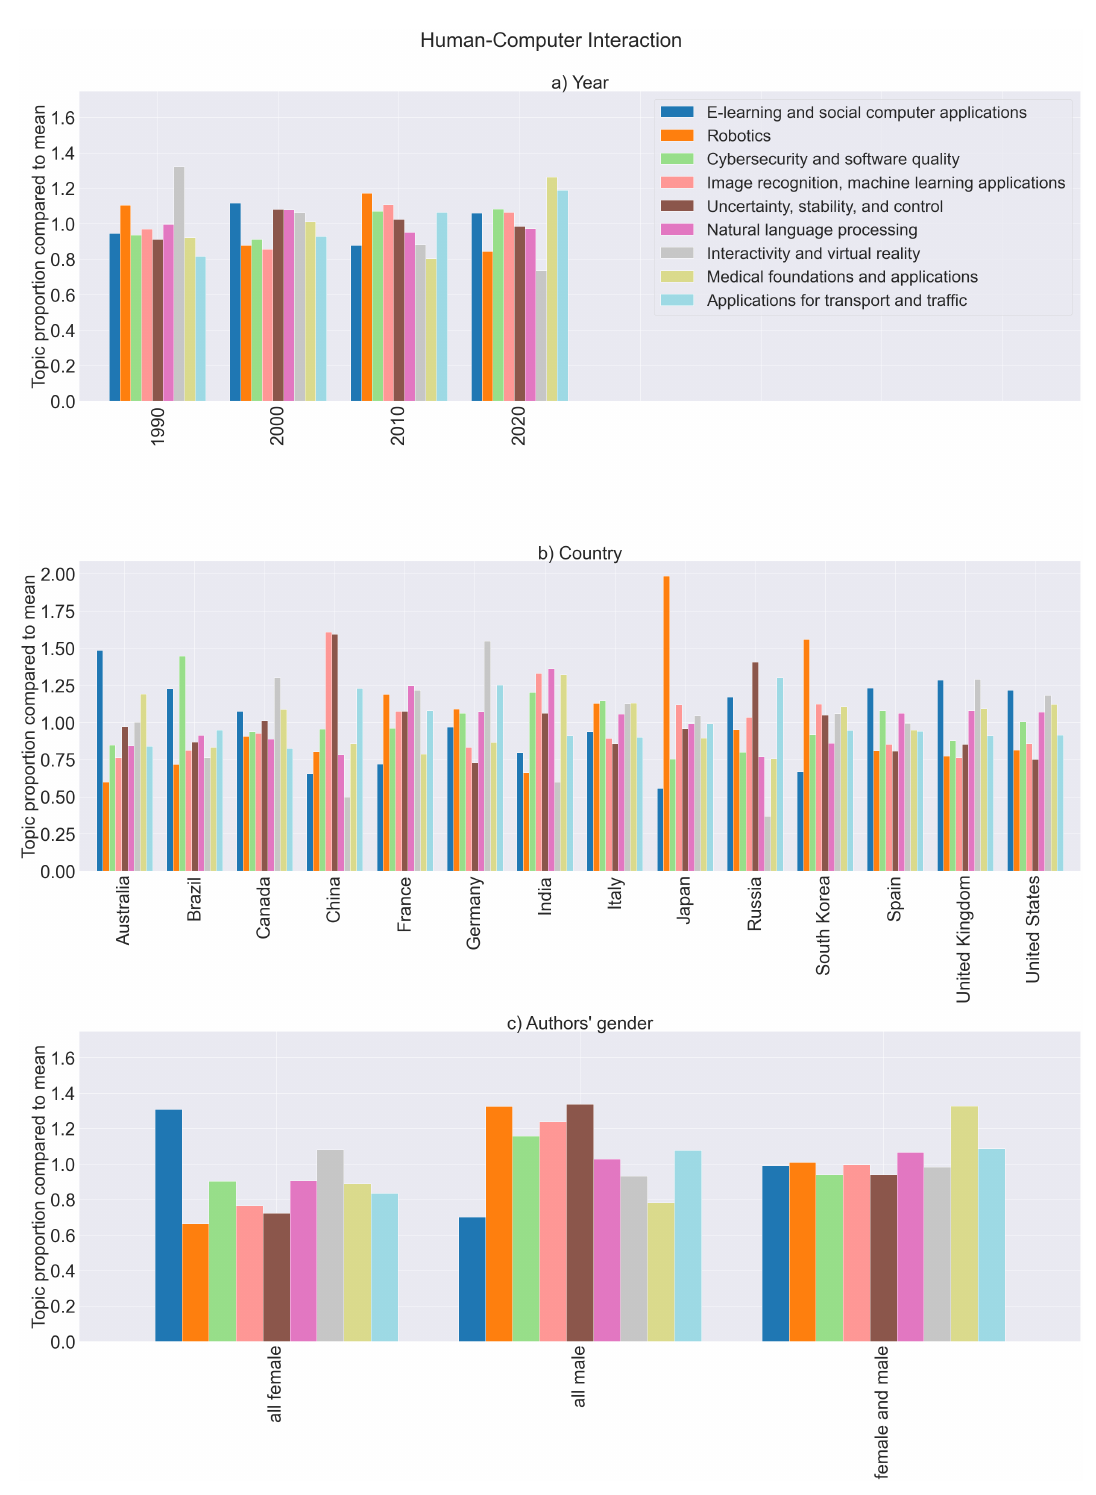
Figure 7. Topic proportion compared to mean, c κ ( ˆ D α ) , for 9 topics of the sub-area human-computer interactions grouped by ( a ) publication year, ( b ) country, and ( c ) authors’ gender. The legend for the topics and their colour codes at the top right corner applies to all three